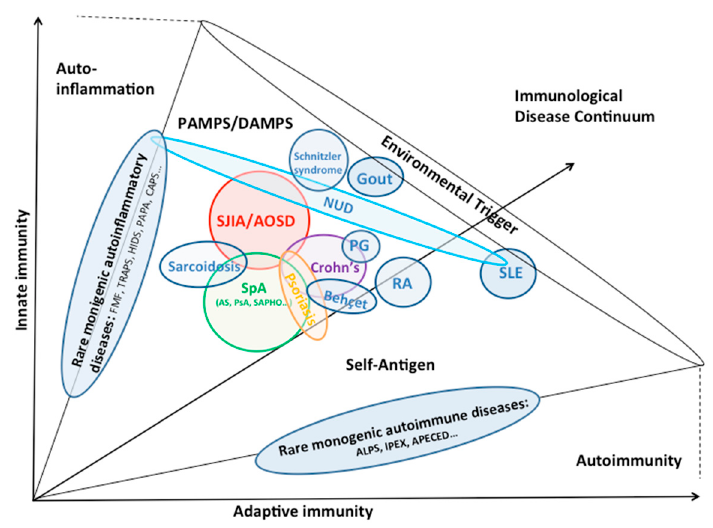
Figure 2. Continuum between AOSD and other autoinflammatory disorders. Diseases of the immune system are classified according to whether the innate immune system (myeloid lineage) is mainly responsible for the disease (autoinflammation) or the adaptive immune system (lymphoid lineage, autoimmunity). A disease spectrum includes rare monogenic diseases at the polar ends of the spectrum, and polygenic diseases, involving both myeloid and lymphoid cells in pathogenesis, in the center. This diagram adds a third variable, environmental triggers, to further define the pathogenesis of these diseases. The figure does not include all immunological recognized diseases, because of their large number, but focuses on the continuum between AOSD and other polygenic autoinflammatory disorders (please note the overlap among certain conditions). It is adapted from [45–47]. AOSD and SJIA are currently considered to be the same disease occurring at different moments of life. ALPS, autoimmune lymphoproliferative syndrome; AOSD, adult-onset Still’s disease; APECED, autoimmune polyendocrinopathy—candidiasis—ectodermal—dystrophy syndrome; AS, ankylosing spondylitis; CAPS, cryopyrin-associated periodic syndrome; DAMPS, danger-associated molecular patterns; FMF, familial Mediterranean fever; HIDS, hyperimmunoglobulinaemia D with periodic fever syndrome; IPEX, immune dysregulation polyendocrinopathy enteropathy X-linked syndrome; NUD, neutrophilic urticarial dermatosis; PAMPS, pathogen-associated molecular patterns; PAPA, pyogenic arthritis-pyoderma gangrenosum-acne syndrome; PG, pyoderma gangrenosum; PsA, psoriatic arthritis; RA, rheumatoid arthritis; SAPHO, synovitis acnea pustulosis hyperostosis osteitis syndrome; SLE, systemic erythematosus lupus; SpA, spondyloarthritis (include ankylosing spondylitis, psoriatic arthritis, reactive arthritis, seronegative arthritis associated with inflammatory bowel diseases and SAPHO syndrome); TRAPS, tumour necrosis factor receptor-associated periodic syndrome.